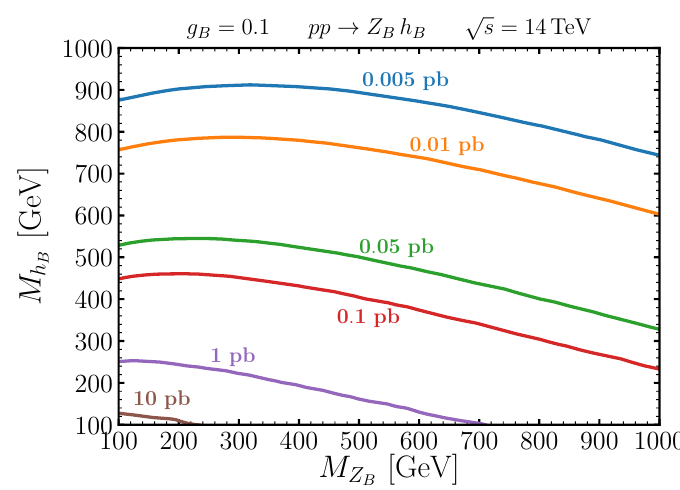
Figure 9 . Contour lines for the production cross-sections for the process pp → Z ∗ LHC with center-of-mass energy of 14 TeV. We show the results in the M results have almost no dependence on the mixing angle for sin θ